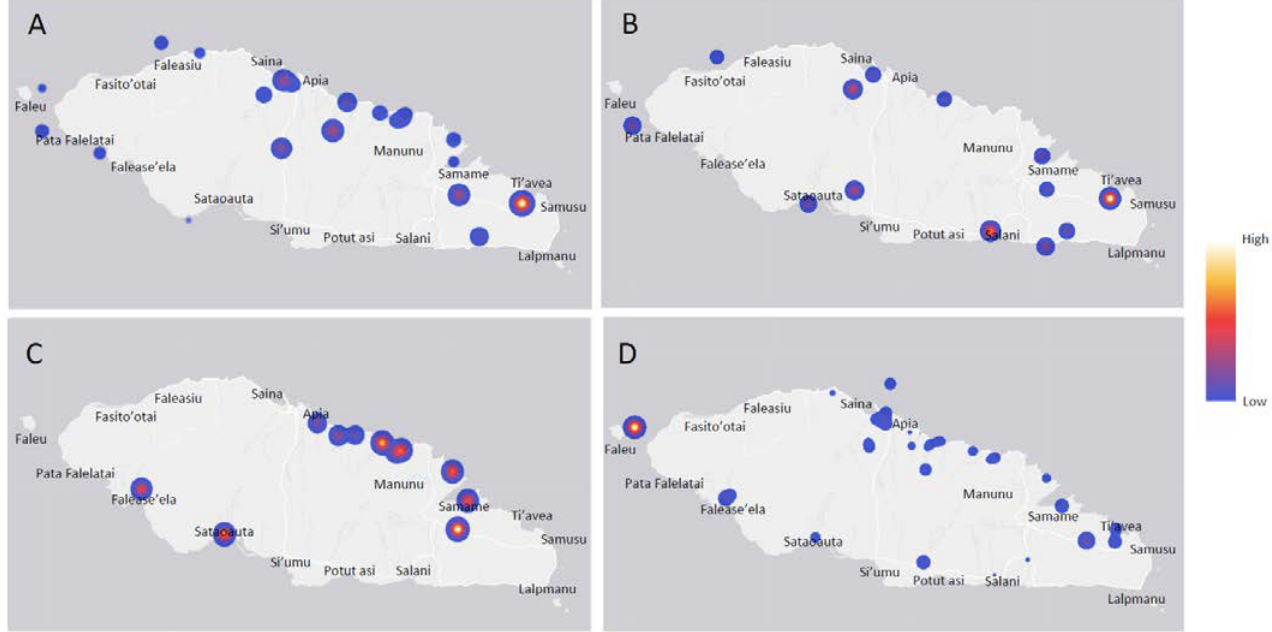
Figure 4. Overview of distribution of ASVs belonging to four potentially pathogenic bacterial genera around Upolu Island based on amplicon sequencing. ArcGIS Distribution maps were overlaid with 16S rRNA total read abundance (dot size). Gradient color of each dot represent relative abundance of ASVs (blue = low; yellow = high) for Escherichia sp. ( A ), Staphylococcus sp. ( B ), Pleisomonas sp. ( C ), and Klebsiella sp. ( D ).